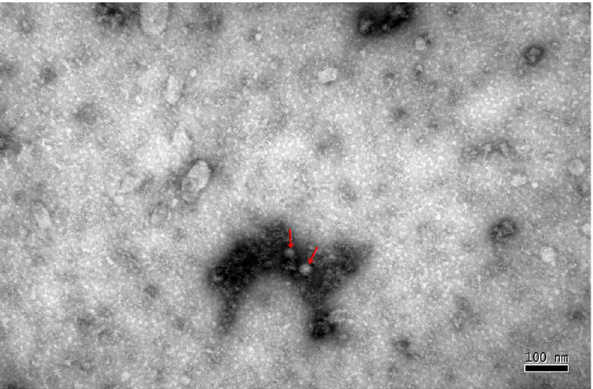
Figure 1. Electron micrographs showing the EMCV-C15 isolate. Virus was concentrated from the tissue culture fluid of virus-infected BHK21 cells. 50,000 × magnification. Scale bar represents 100 nm.